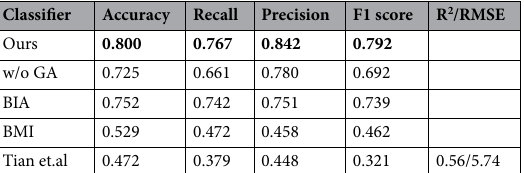
Table 7. Comparison between our method, BMI, BIA and Tian et al. within the test set. w/o without, GA genetic algorithm. Significant values are in bold.